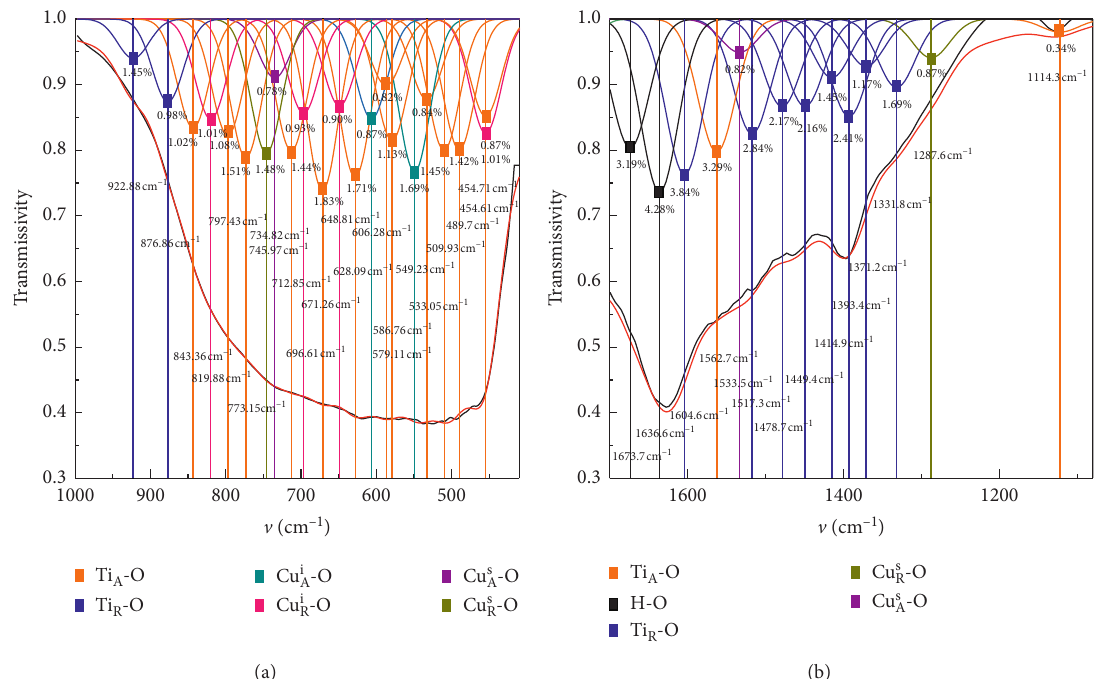
Figure 7: Infrared spectra of the 5mol% Cu-doped TiO 1000cm − 1 ∼ 1800cm − 1 Table 6: Infrared spectra of the 5mol%Cu-doped TiO The type of bond Content (%)